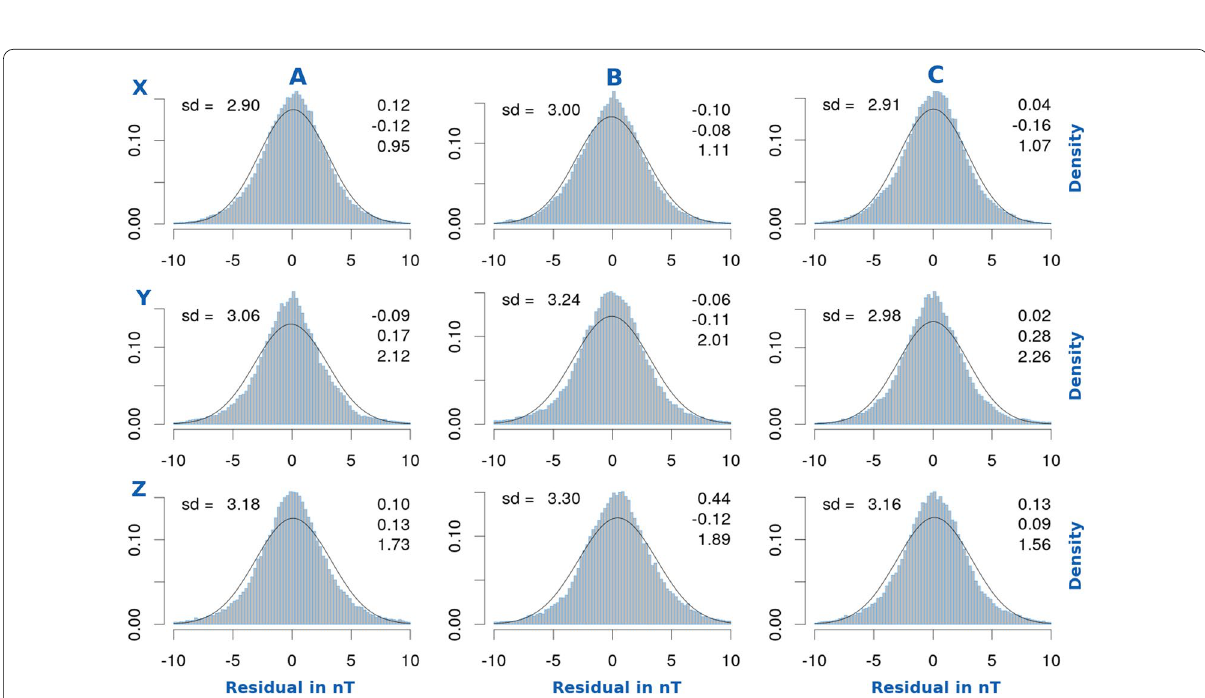
Fig. 4 Histograms of the residuals for the three components X, Y, Z at low and mid latitudes in geocentric solar ecliptic coordinates for Swarm satellites Alpha (A, left), Bravo (B, middle) and Charlie (C, right) for the entire time of Mag.num . A Gaussian distribution corresponding to the calculated standard deviation (sd) of each distribution is indicated as black line. The distribution’s mean, skewness and excess kurtosis are given in the top right of each